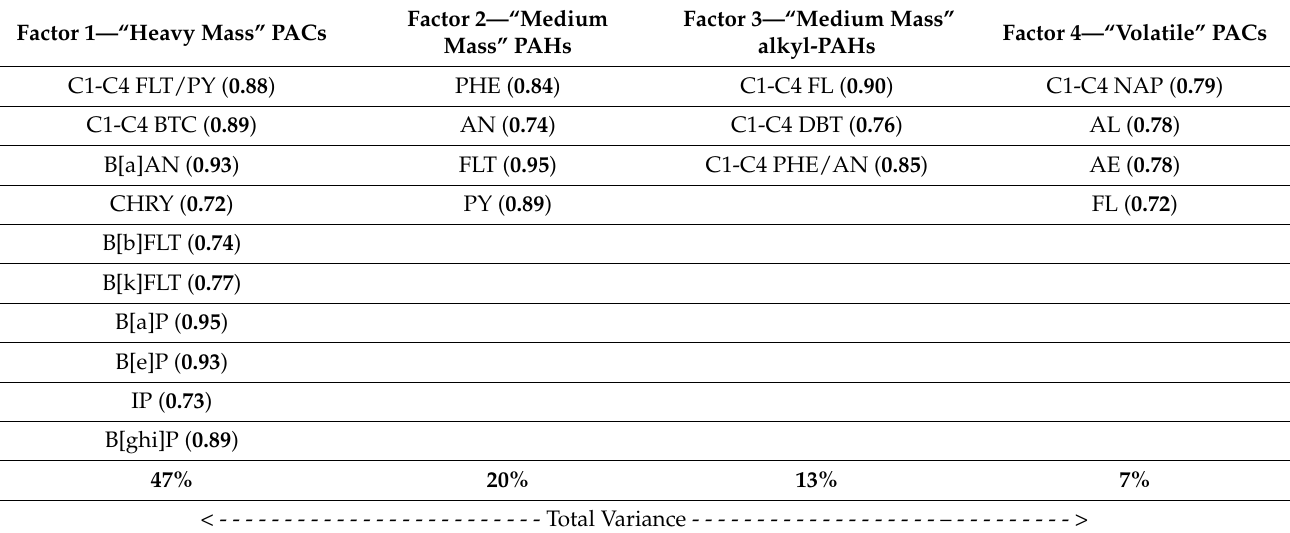
Table 2. Factor Analysis of PAC concentrations for monitored sites